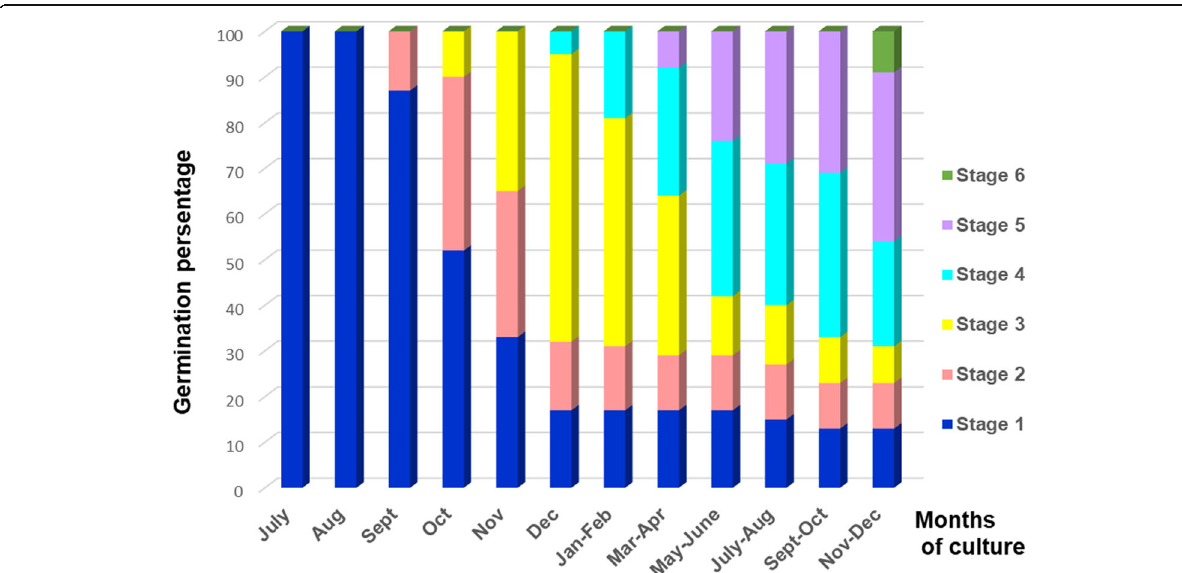
Fig. 3 Germination percentage during different stages of Orchis militaris seed development scored monthly on mHar2 and mKC + AC media and 2-monthly on mM + OA